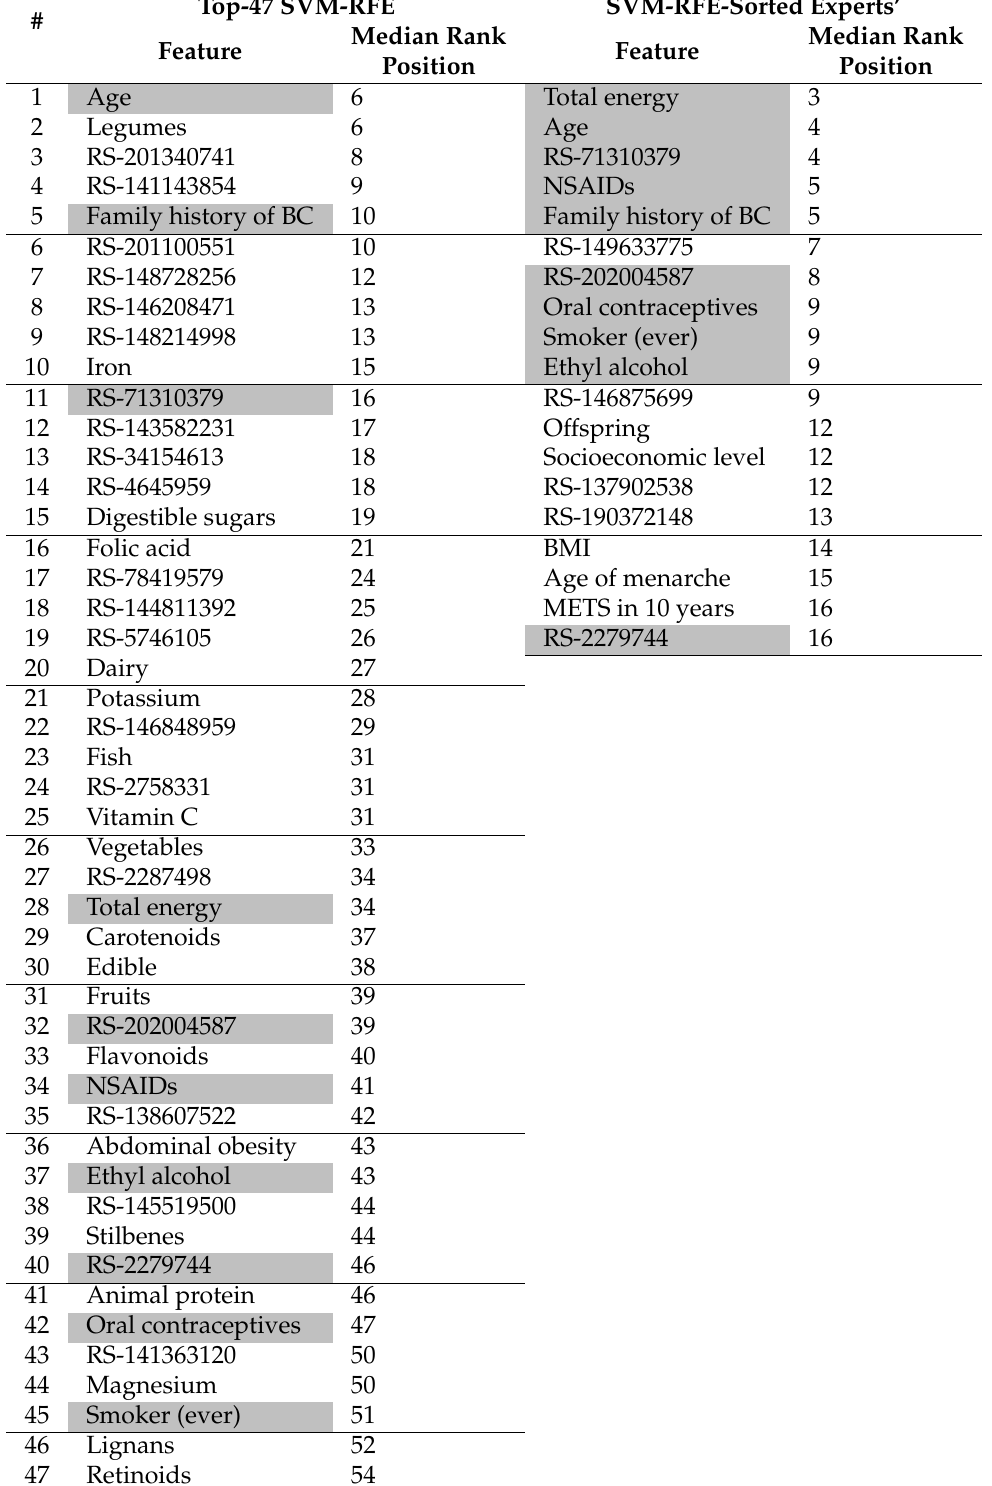
Table 10. Top-47 SVM-RFE features and top expert selected features. Features highlighted are those that have also been found relevant in our